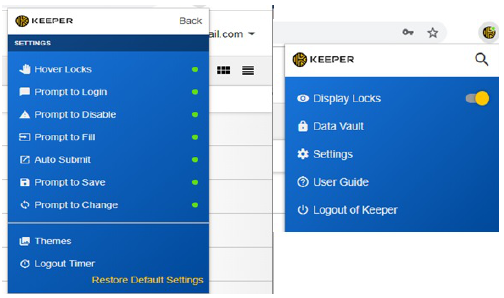
Figure A24. Keeper does not have a random password generator in the browser